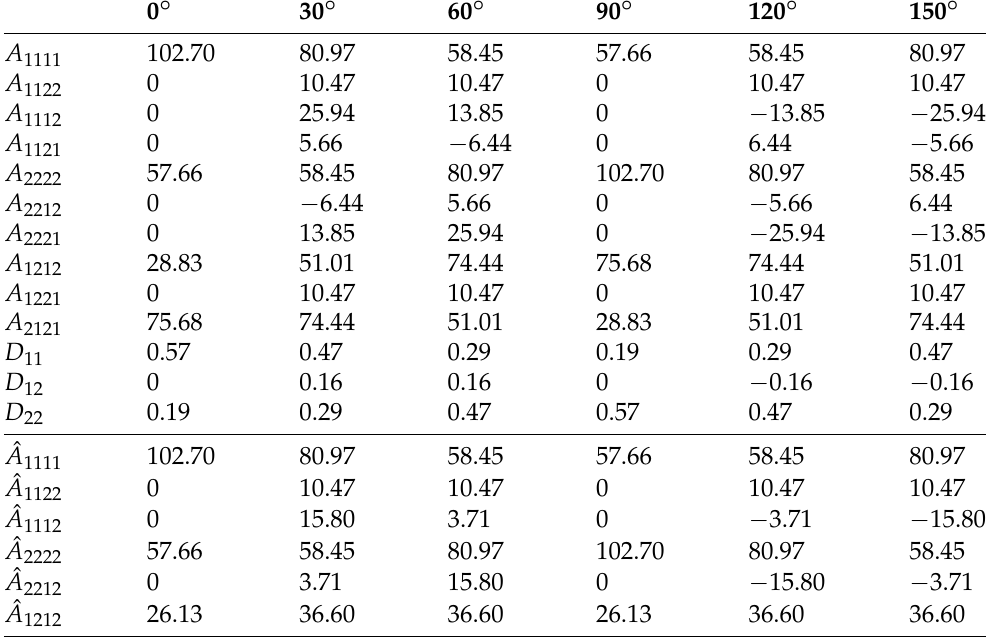
Table 1. Cosserat and Cauchy constitutive parameters for RVE with block parameter ρ =